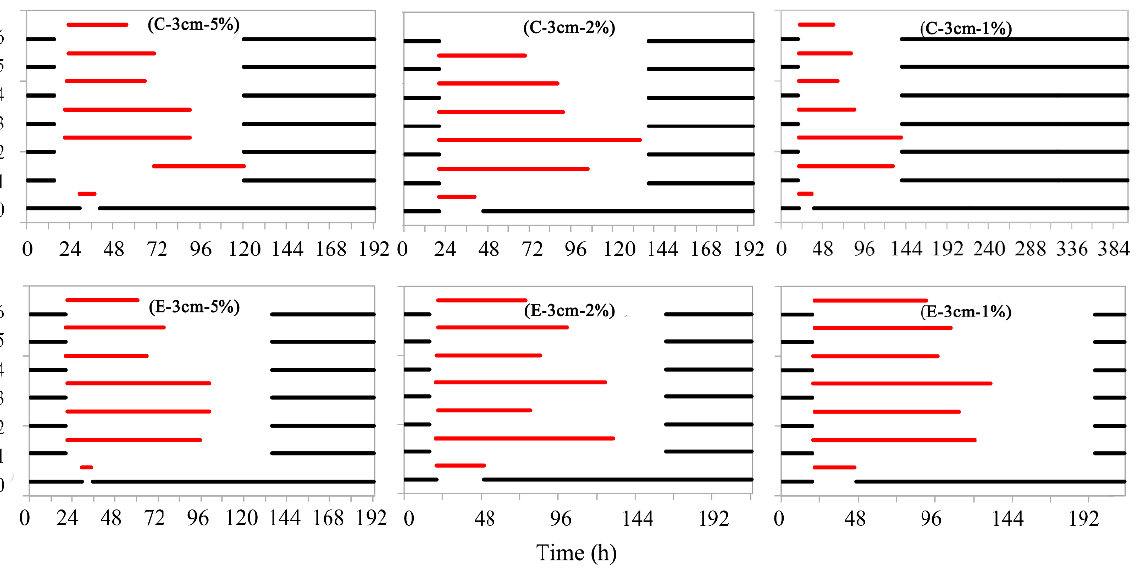
Figure 10. Waterlogging loss of paddy fields with an initial storage depth of 0 cm under different rainfall frequencies.